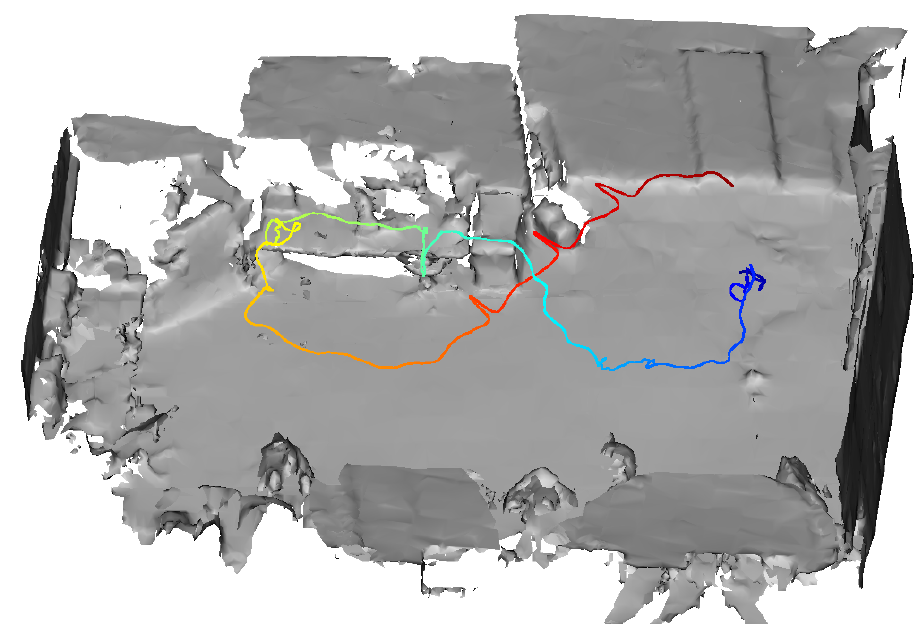
Figure 13. HoloLens trajectory in a room equipped with a Motion Capture System. The color represents time. The trajectory starts at blue and ends at red. The evaluation results in Figure 14 also refer to this trajectory. They are visualized in the same color range representing